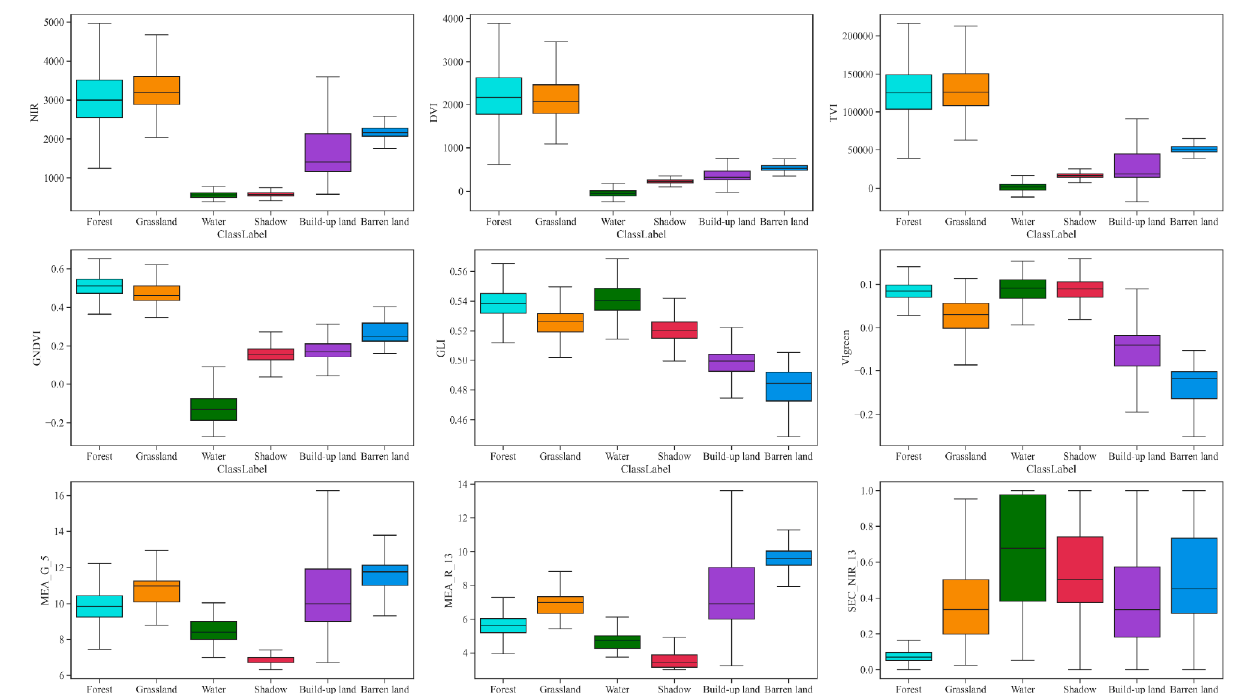
Figure 11. Preferred feature index. The centerline in each box in the boxplot is the median, and the edges of the box represent the upper and lower quartiles. Spectral characteristics: NIR; vegetation indexes: GLI, GNDVI, TVI, DVI, and VIgreen; texture feature: MEA_G_5, MEA_R_13, and SEC_NIR_13.